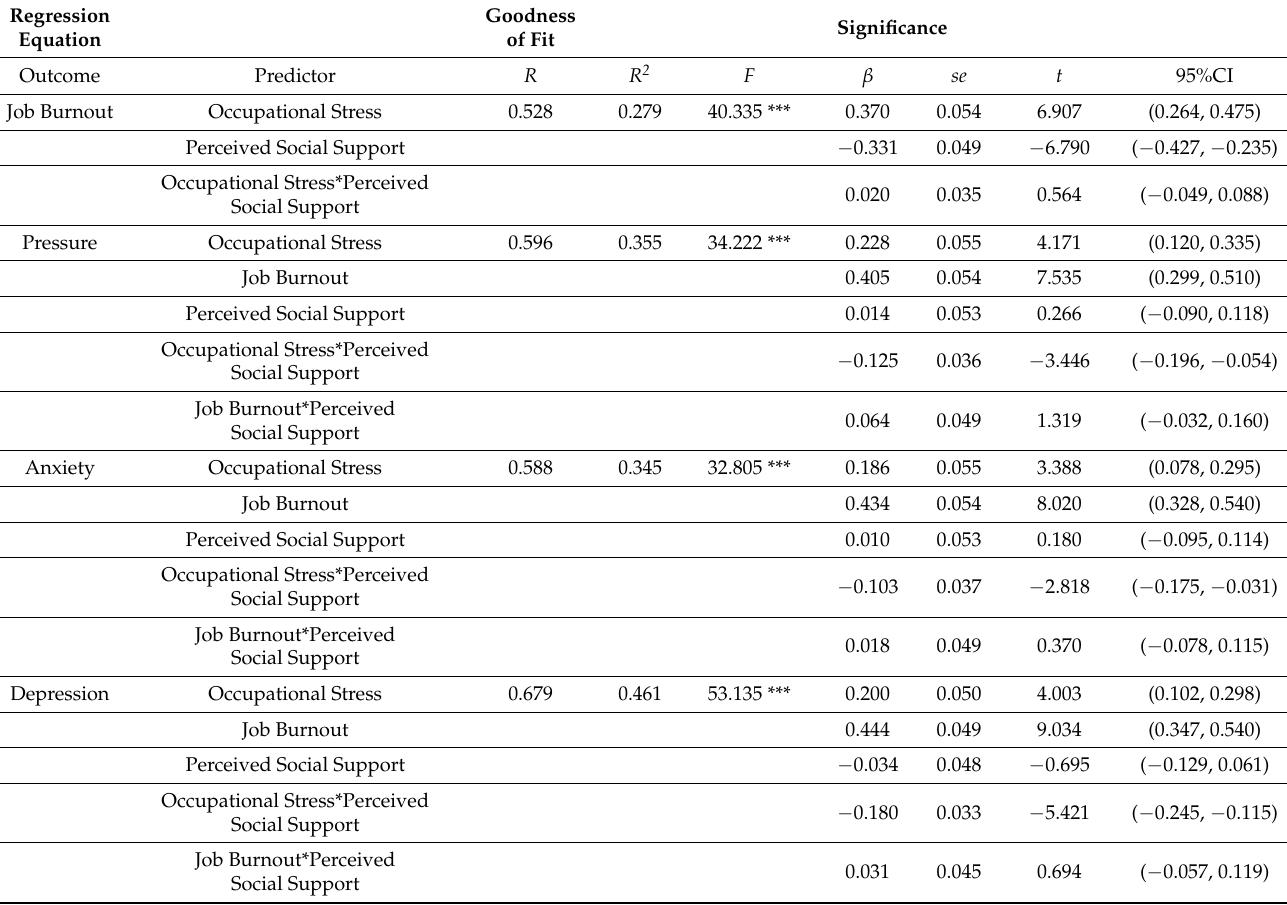
Table 2. Testing for moderated mediation effects of job burnout and perceived social